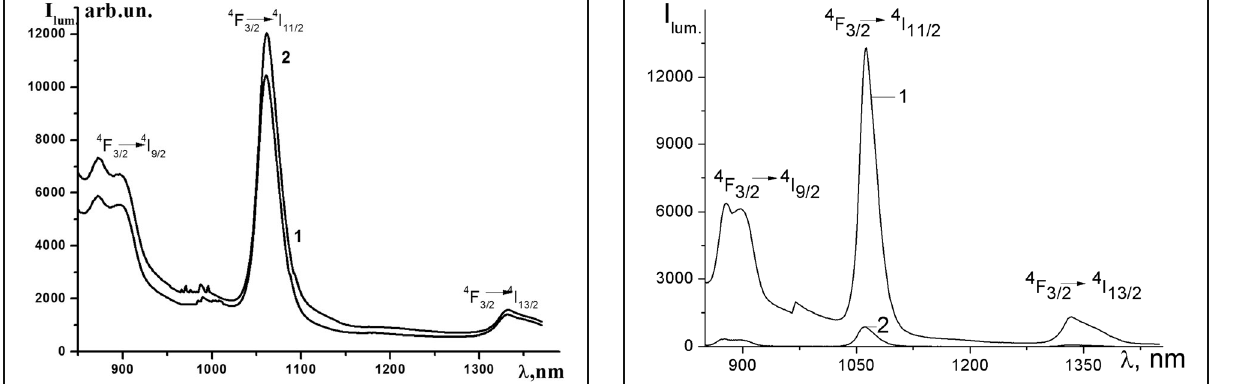
Fig. 5 Emission spectra of Nd(alacac) 3 ( 1 ) and [Nd(alacac) 3 ] n ( 2 ) in solid state (powder) T = 25 °C, λ = 362 nm